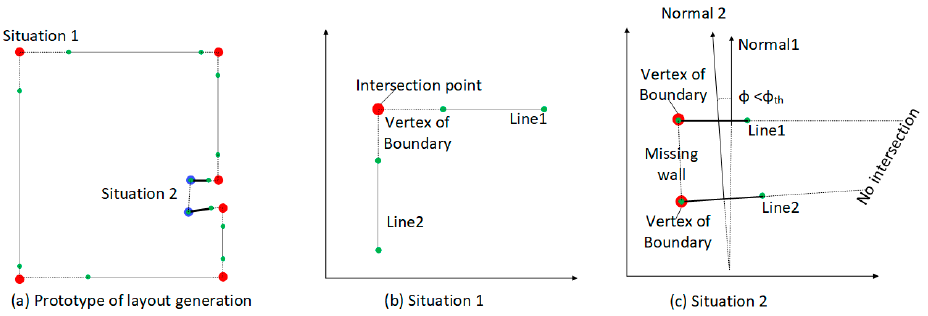
Figure 7. Determination of space layout.